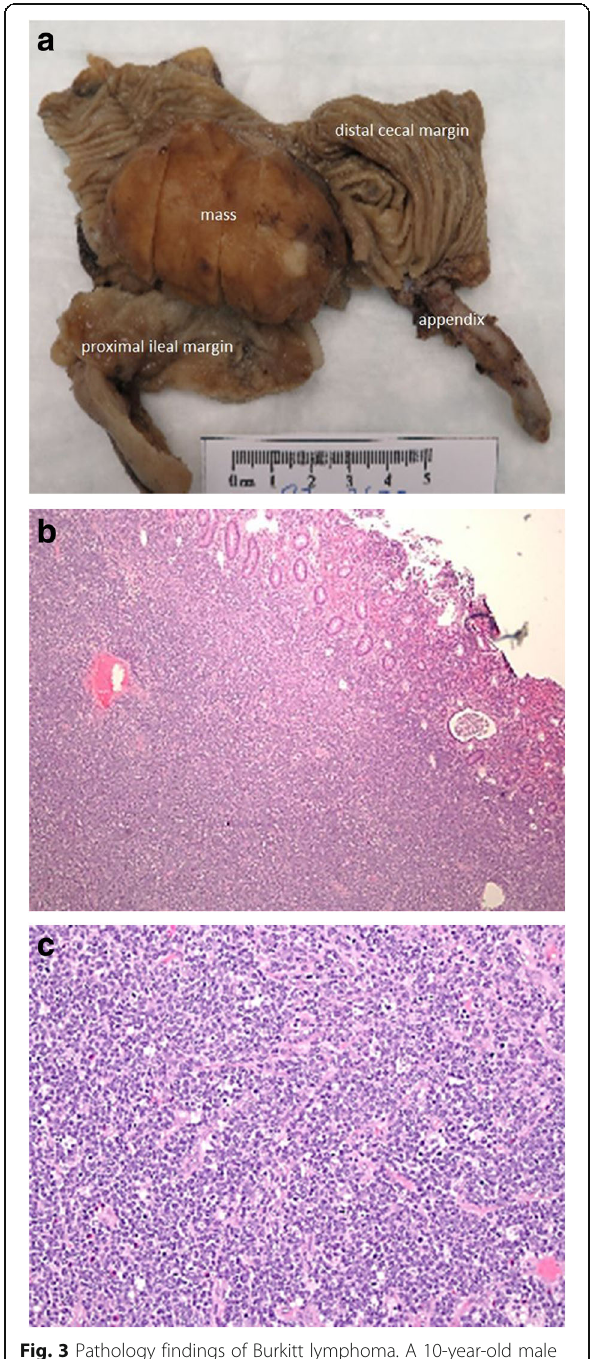
Fig. 3 Pathology findings of Burkitt lymphoma. A 10-year-old male (presented in Fig. 2). a Gross exam shows a 6 cm firm mass at the ileo-cecal junction. Microscopically, ( b ) (× 40) the lymphoma is composed of sheets of monotonous lymphocytes invading the bowel mucosa and cells ( c ) (× 200) has a characteristic “ starry sky ” appearance due to the presence of scattered histiocytes engulfing apoptotic